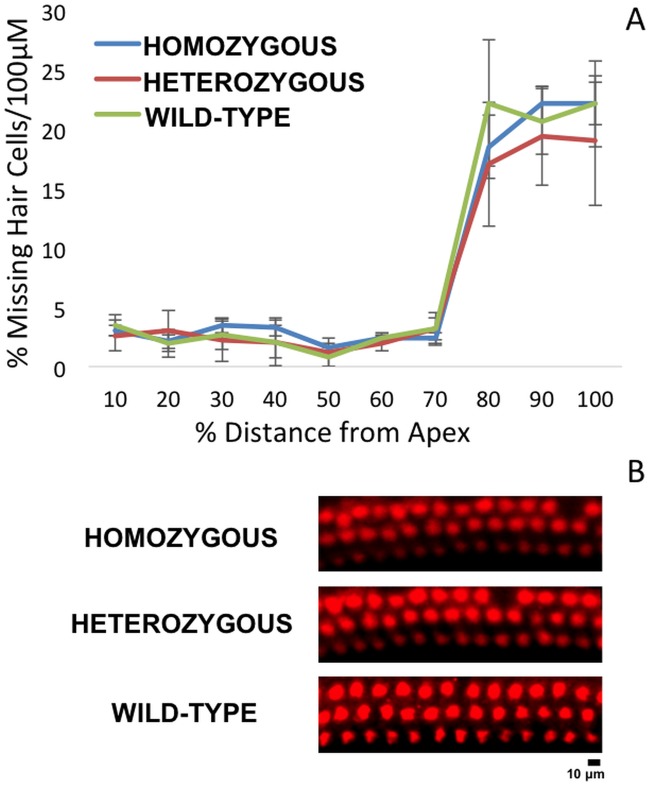
Cytocochleogram of wild-type and mutant Nox3 mice (8A).No significant difference in OHC counts were detected among wild-type, Nox3
het/+ and Nox3
het/Nox3
het. OHC preparations of immunostained (40x) post-noise exposure cochleae (8B) at the 8 kHz tonotopic location (red, rabbit anti-myosin6) demonstrate a small impact with the loss of apical OHC (2 weeks post-noise exposure). Homozygous = Nox3
het/Nox3
het: Heterozygous = Nox3
het/+: Wild-type = C57BL/6JEiJ strain.